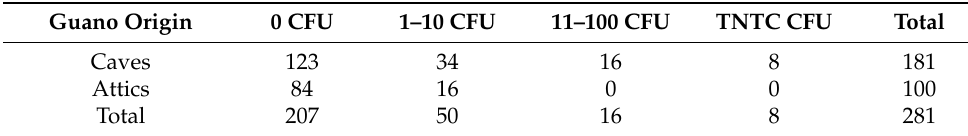
Table interpretation. CFU = colony forming units; TNTC = too numerous to count.